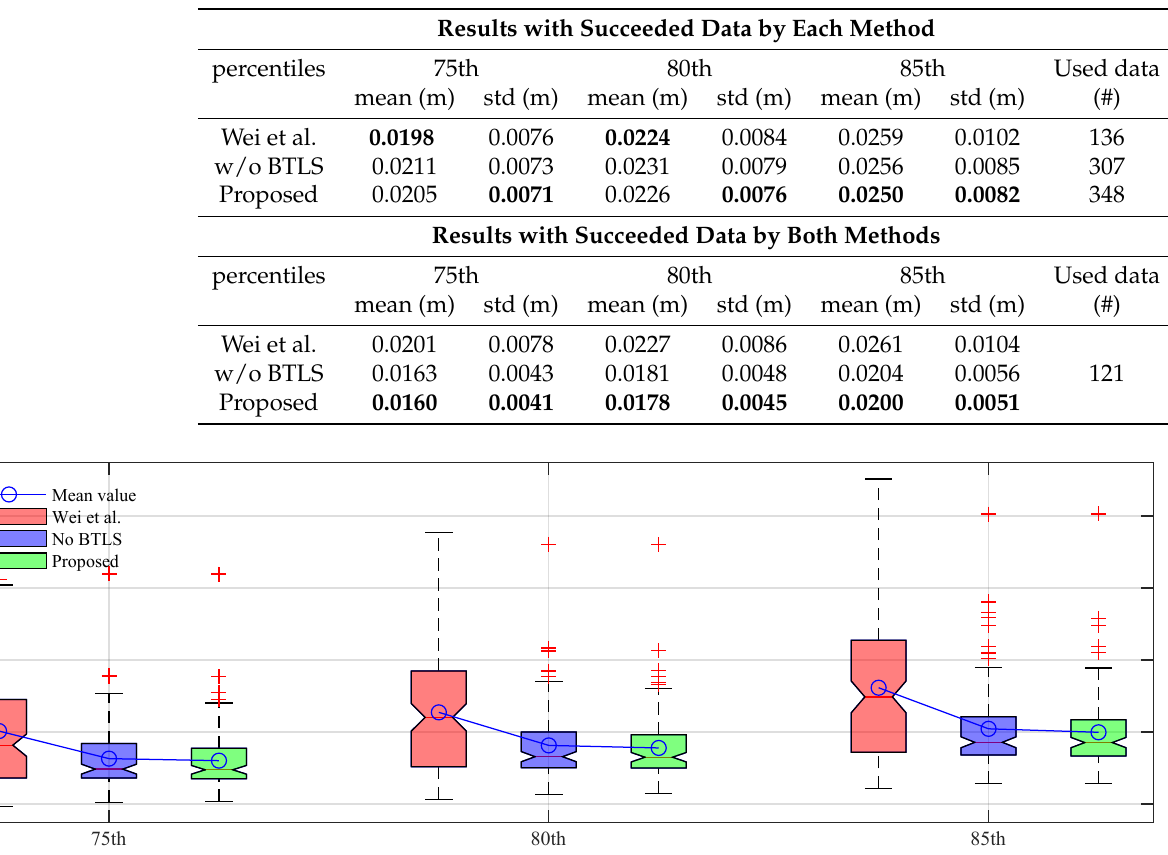
Table 5. Performance comparison based on distance metric.